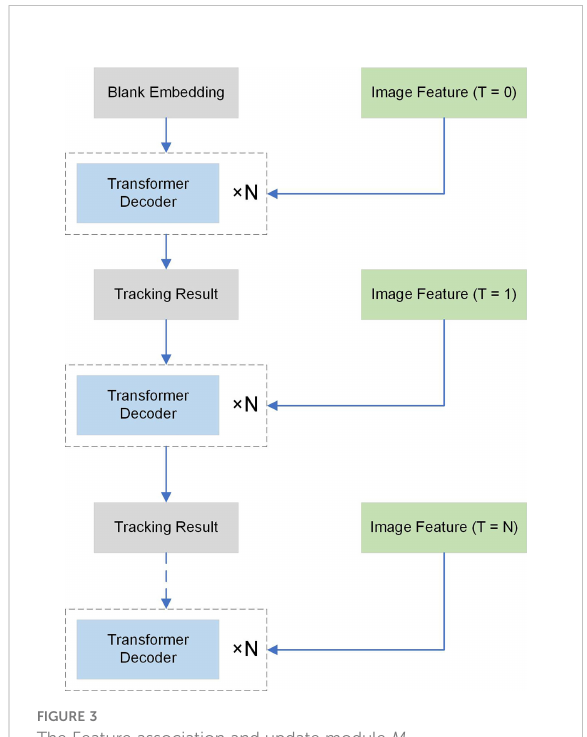
FIGURE 3 The Feature association and update module M A